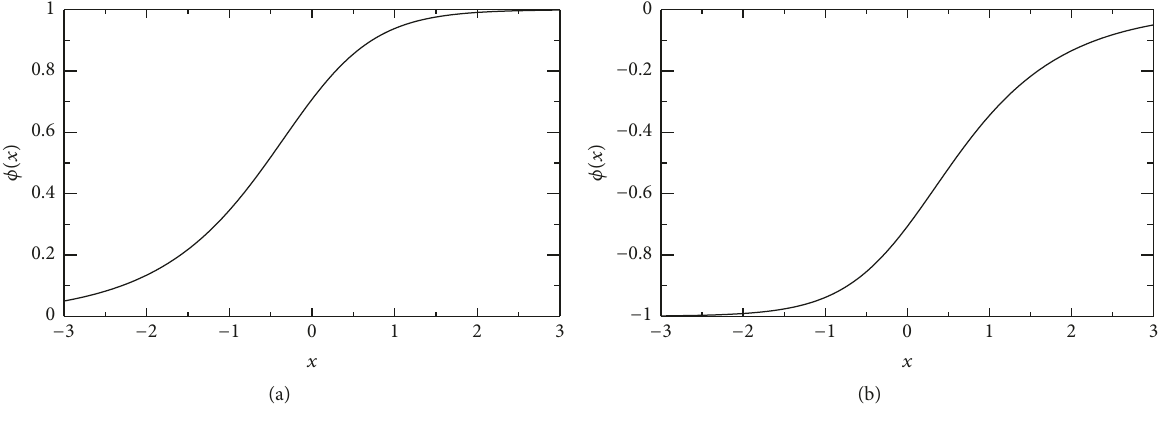
Figure 2: The two soliton solutions for 𝑎 = 0 : (a) see (5); (b) see (6).